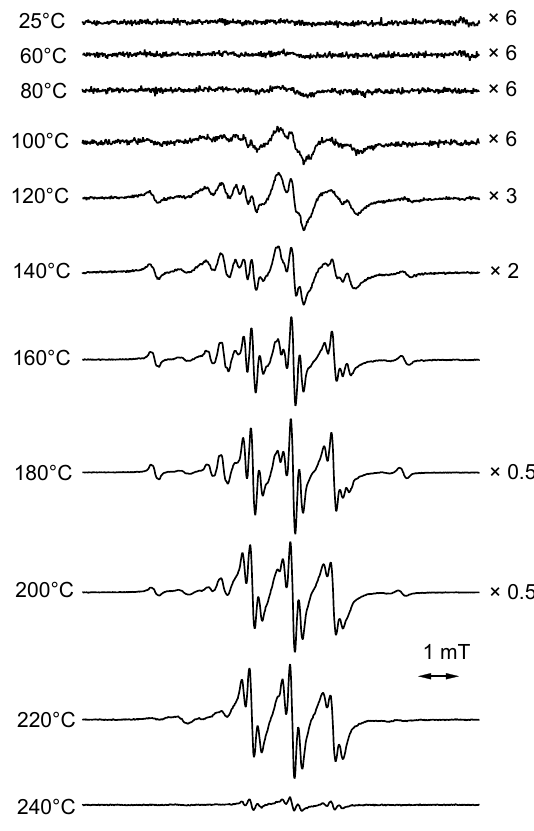
Figure 4. ESR spectra of PA66/TTBNB during stepwise heating from RT to 240 °C at 20 °C intervals.